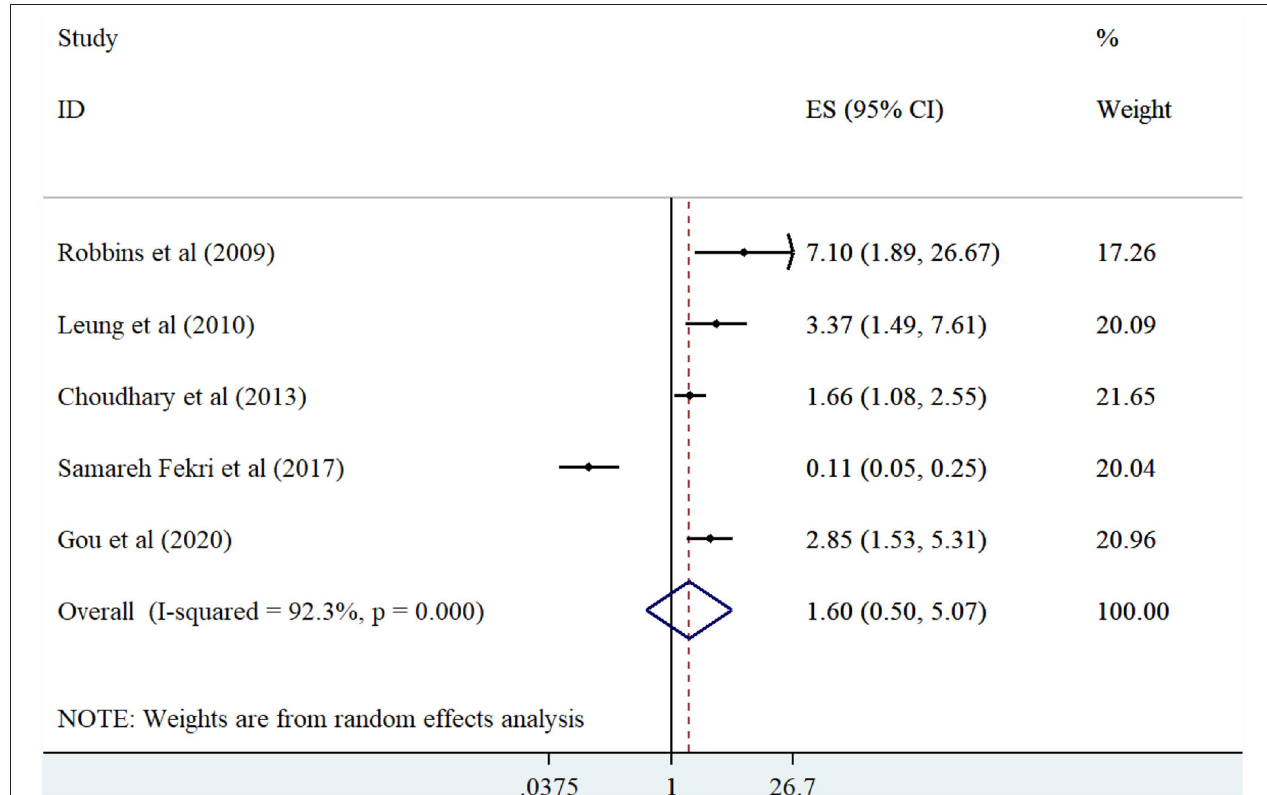
FIGURE 2 | Forest plot derived from random-effects meta-analysis of studies investigating the association between BMI (high vs low) and pulmonary hypertension in adults. CI, confidence interval; ES, effect